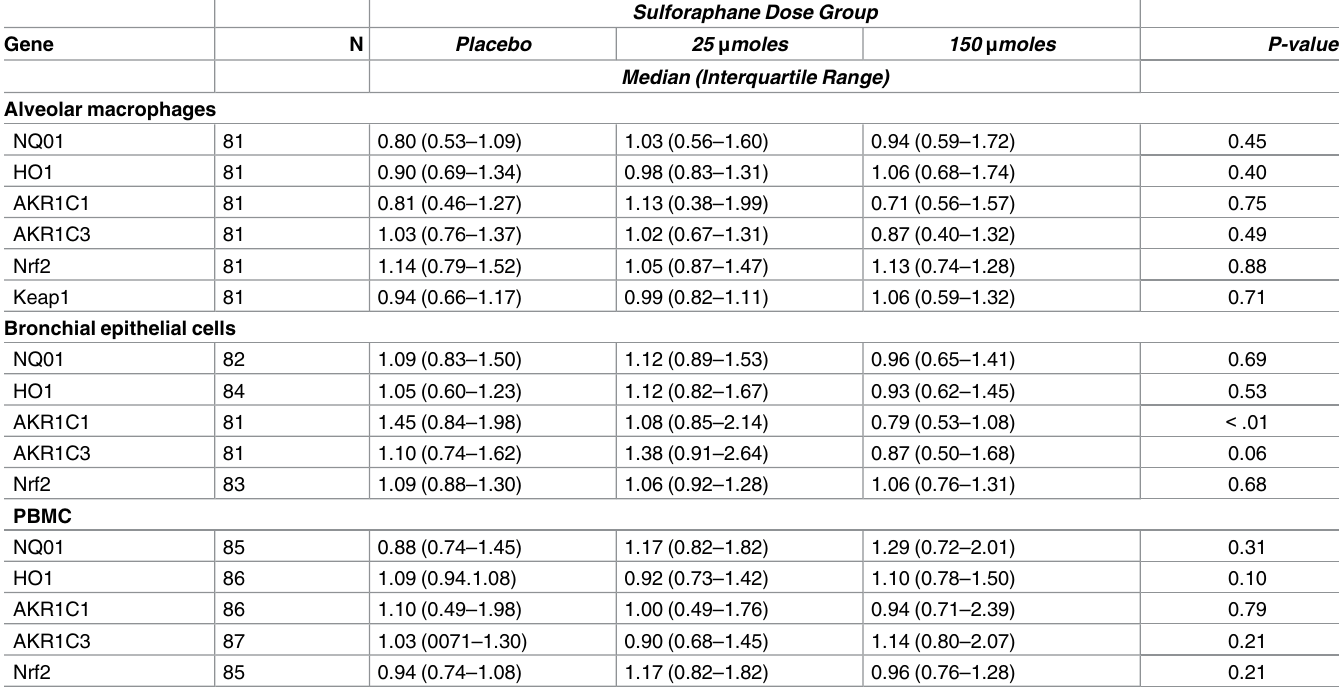
Table 3. Fold-change * in genetic expressionin bronchial epithelial cells and alveolar macrophages by treatment group.